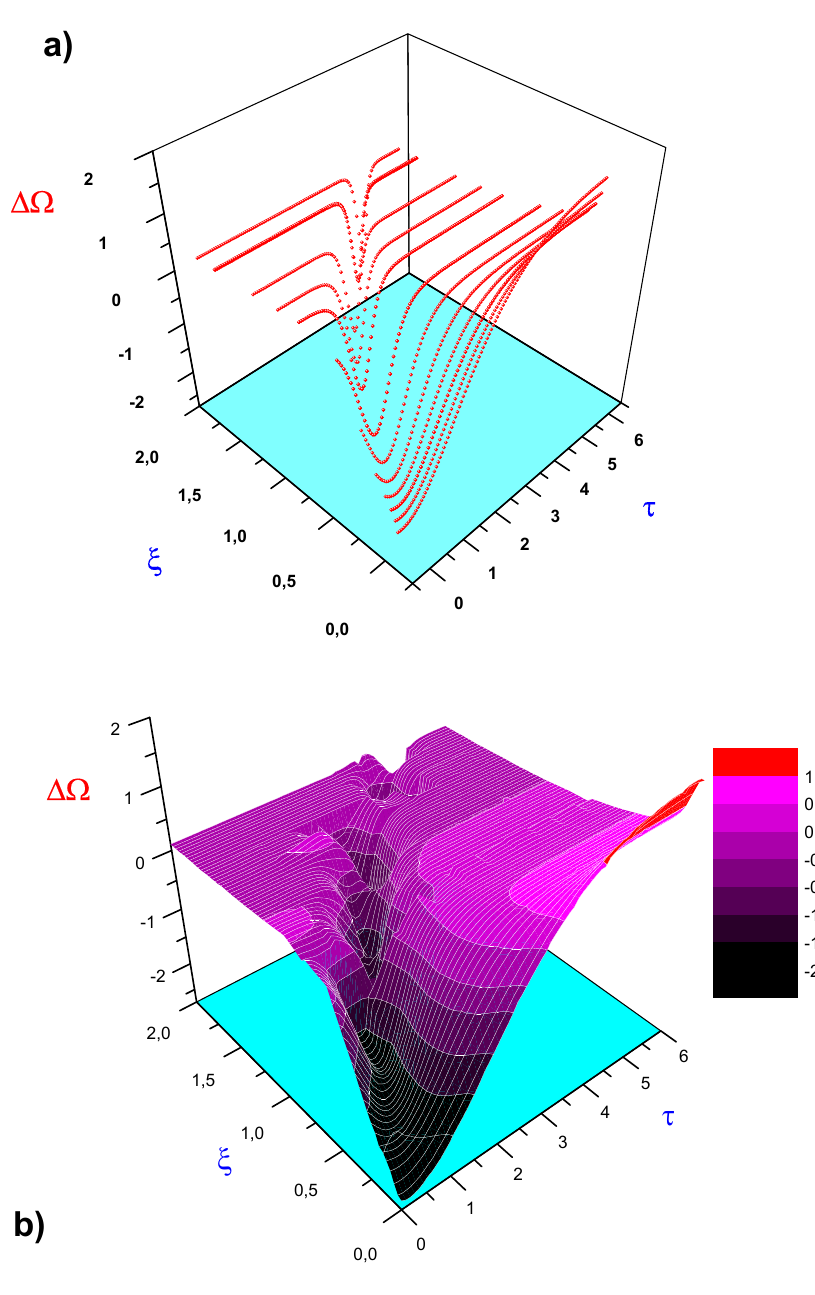
Figure 5. illustrates the propagation behavior of the ∆Ω∆Ω∆Ω in the plane ( ξ , τ )( ξ , τ )( ξ , τ ) . Both graphs, the first showing the scattered points in the panel (a) and the second related to the level surfaces represented in the panel (b), show that in deep waters ( ξ ≈ 0 ξ ≈ 0 ξ ≈ 0 ) the waveform ∆Ω∆Ω∆Ω is a deeper trough (see color scale in bottom panel–b), and it becomes a hole soliton in intermediate waters ( ξ ≈ 1 ξ ≈ 1 ξ ≈ 1 ), but it cannot propagate in shallow waters as ξ → ∞ ξ → ∞ ξ → ∞ .